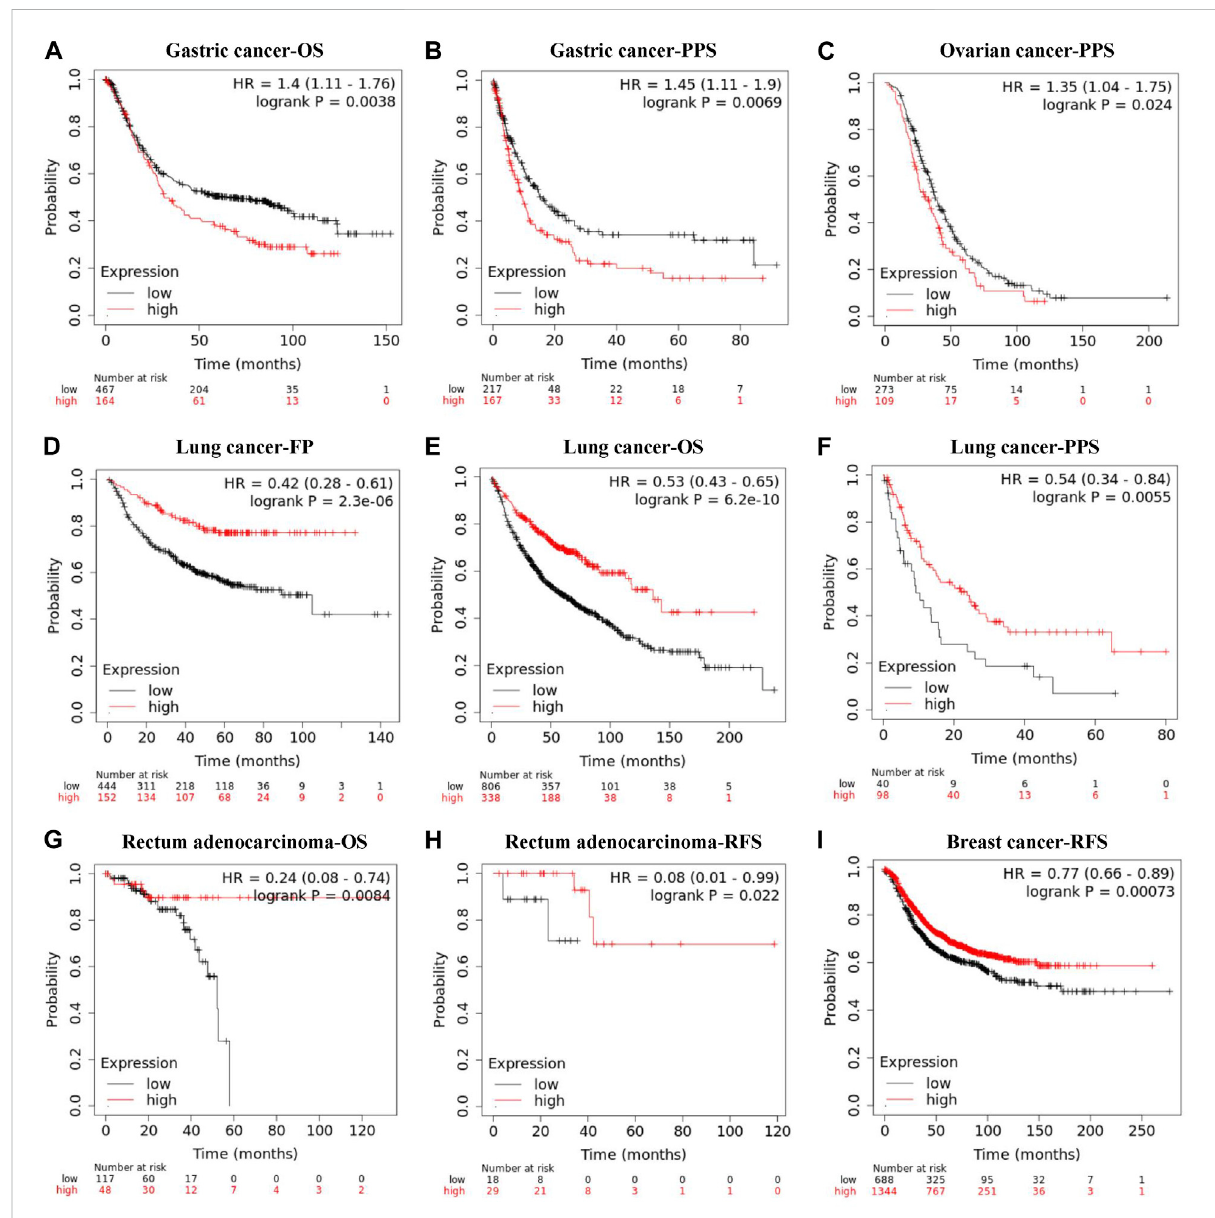
FIGURE 9 Correlation between REV1 expression and prognosis of various types of cancer [gastric cancer (A, B) , ovarian cancer (C) , lung cancer (D – F) , rectum adenocarcinoma (G, H) , and breast cancer (I) ] (Kaplan-Meier Plotter